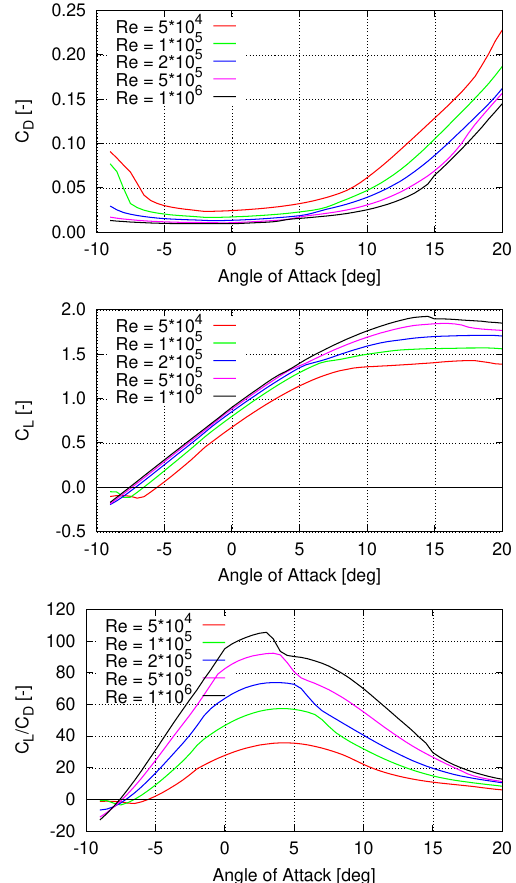
Fig. 9. Baseline profile, t max = 0 . 135 and f max = 0 . 06 : drag, lift ,C coefficients C , and efficiency C L D Reynolds number. Numerical predictions by X-Foil code.